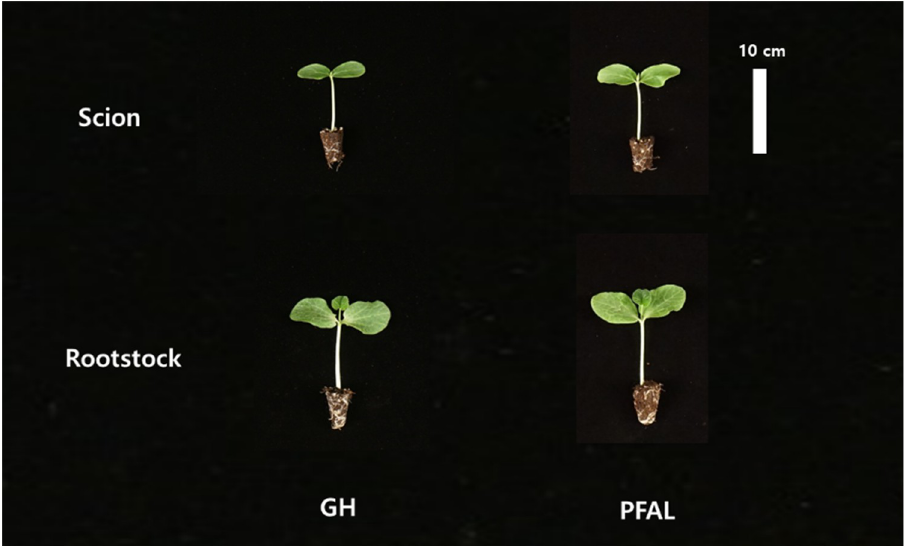
Figure 7. Cucumber scions and rootstocks cultivated in a plant factory with artificial lighting (PFAL) and greenhouse (GH).